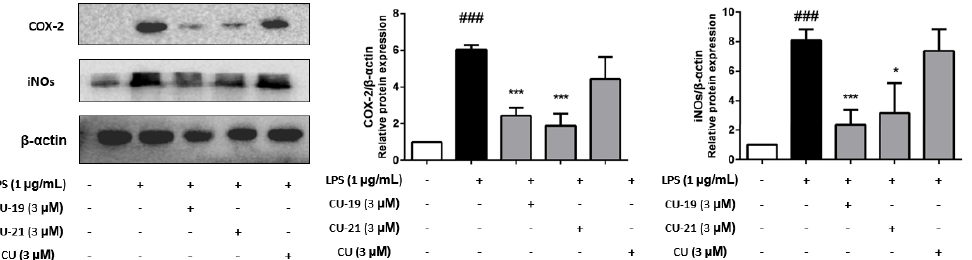
Figure 4. The ability of CU-19 , CU-21 and CU to inhibit LPS-induced COX-2 and iNOS expression. BV2 cells were pretreated with CU-19 , CU-21 and CU (3 μM ) for 1 h, followed by stimulation with LPS (1 μg/mL) for 24 h. Results were the mean ± SD, n = 3; ### p < 0.001 vs. control; * p < 0.05, *** p < 0.001 vs. LPS alone.